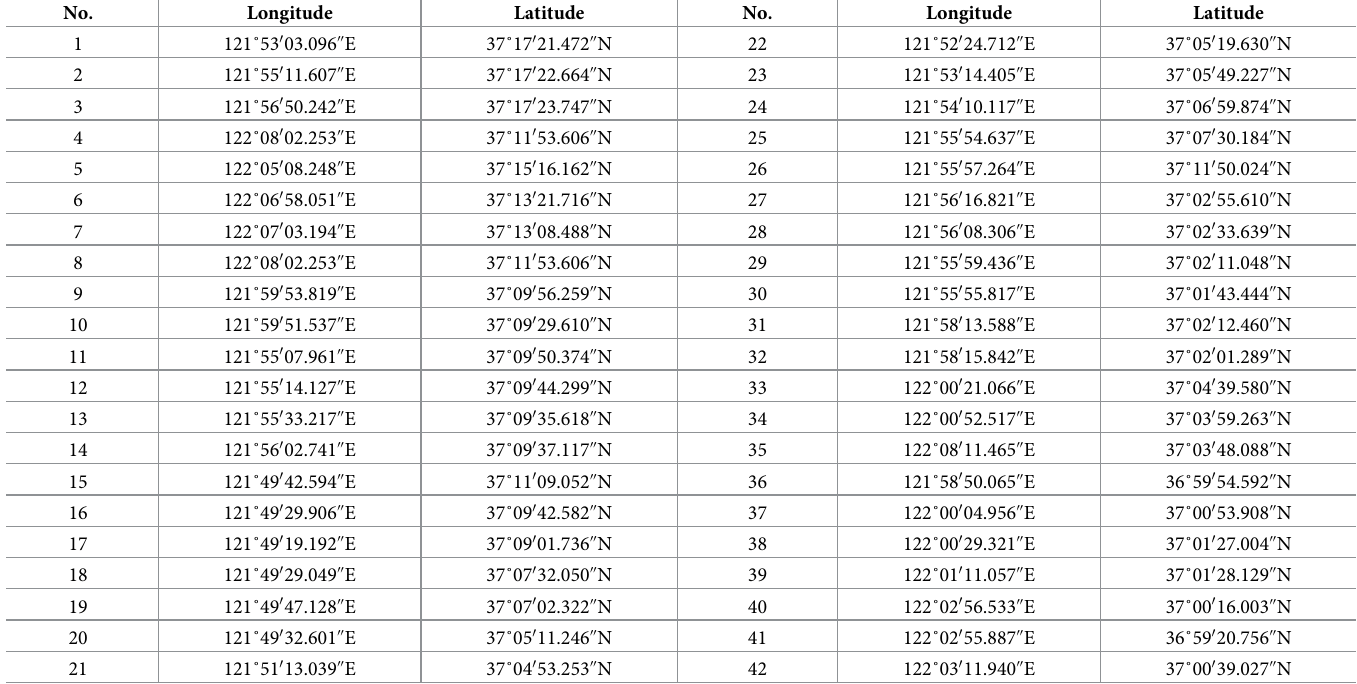
Table 1. The geographic coordinates for the data set.